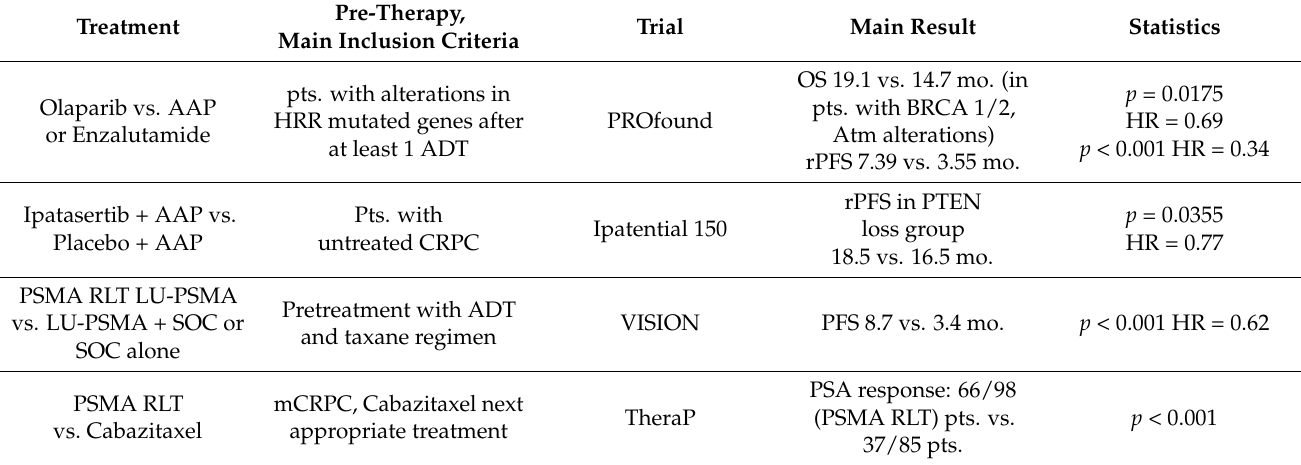
Table 6. Molecular